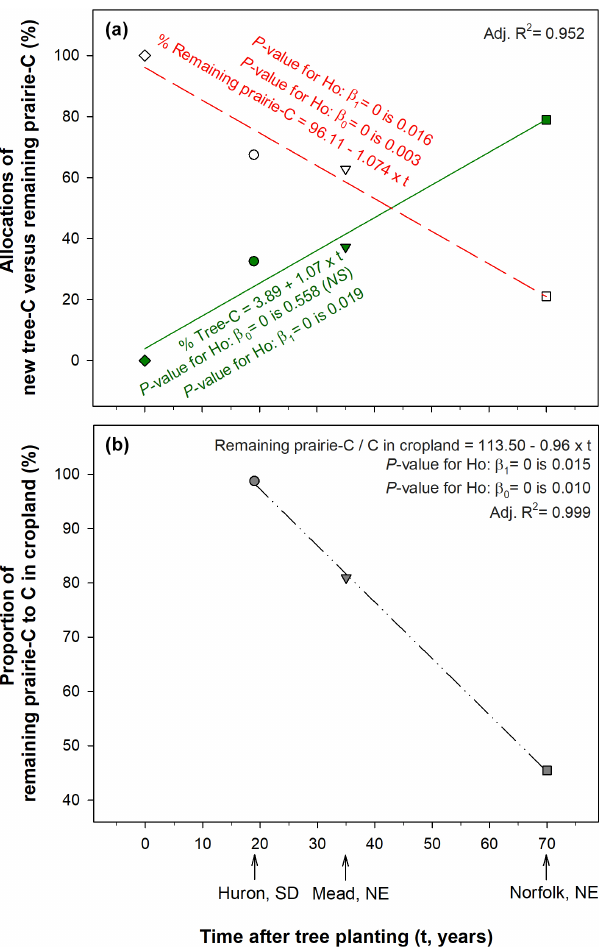
Figure 5. Proportions of soil organic carbon within 0 to 15cm depth increment (a) from tree C versus remaining prairie C rela- tive to whole-soil C stored directly beneath trees and (b) remaining prairie C in afforested soils relative to whole-soil C in the adjacent croplands. It was inferred that all soil C different from new tree C was pre-existing soil C attributable to remaining prairie C. (a) Mead data were recalculated from Hernandez-Ramirez et al. (2011) as compiled in Table 3. The tree-C source increased to become 79% of the whole-soil C over 70 years after tree planting. (b) The propor- tion of prairie-derived C beneath trees declined over time to become less than half (45%) of the whole-soil C in the adjacent annual crop- lands, which were assumed to be at steady